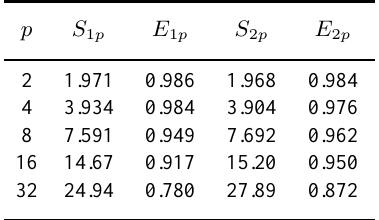
Table 1. The speed-up and efficiency of the parallel